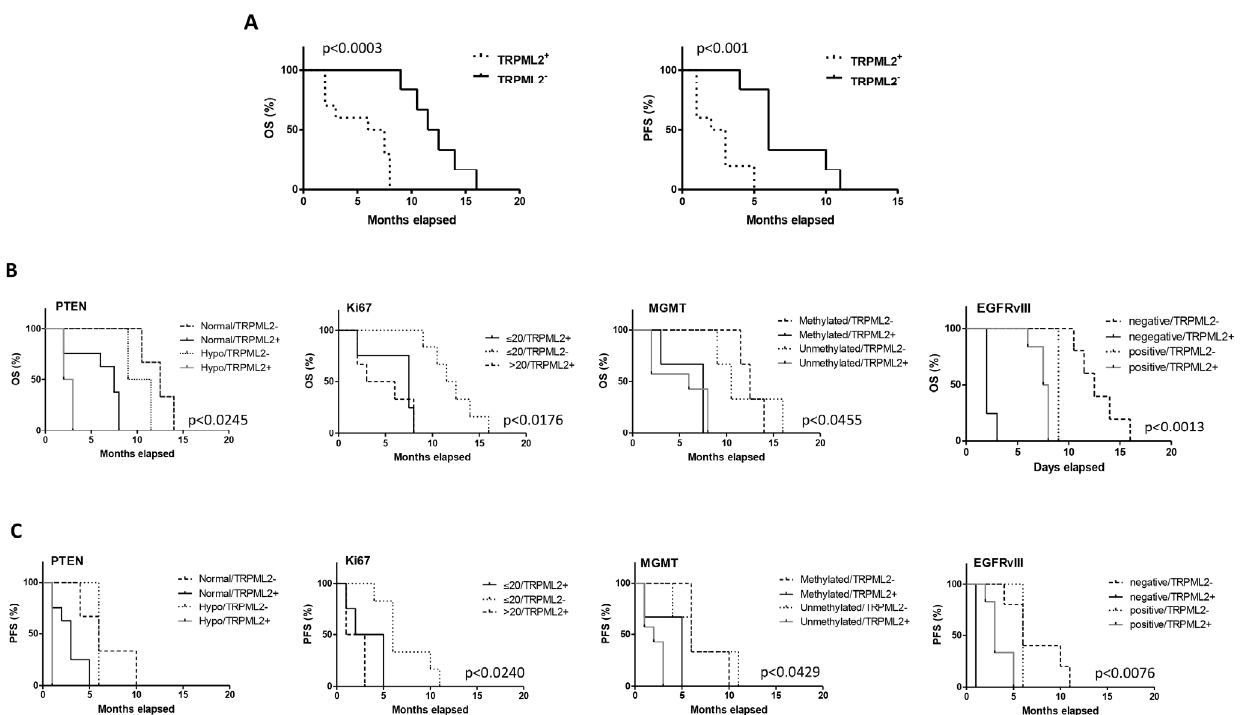
Figure 8. Survival analysis by Kaplan–Meier curves and long-rank (Mantel–Cox) test. Stratification of GBM patients based negative or positive TRPML2 expression ( A ), PTEN hypophosphorylated /normal, Ki67 positivity, MGMT methylation status, EGFRvIII positive/negative ( B , C ). Moreover, the OS and PFS in methylated or unmethylated MGMT, high > 20 vs. low ≤ 20 Ki67, PTEN normal vs. hypophosphorylated and EGFRvIII negative vs. positive in